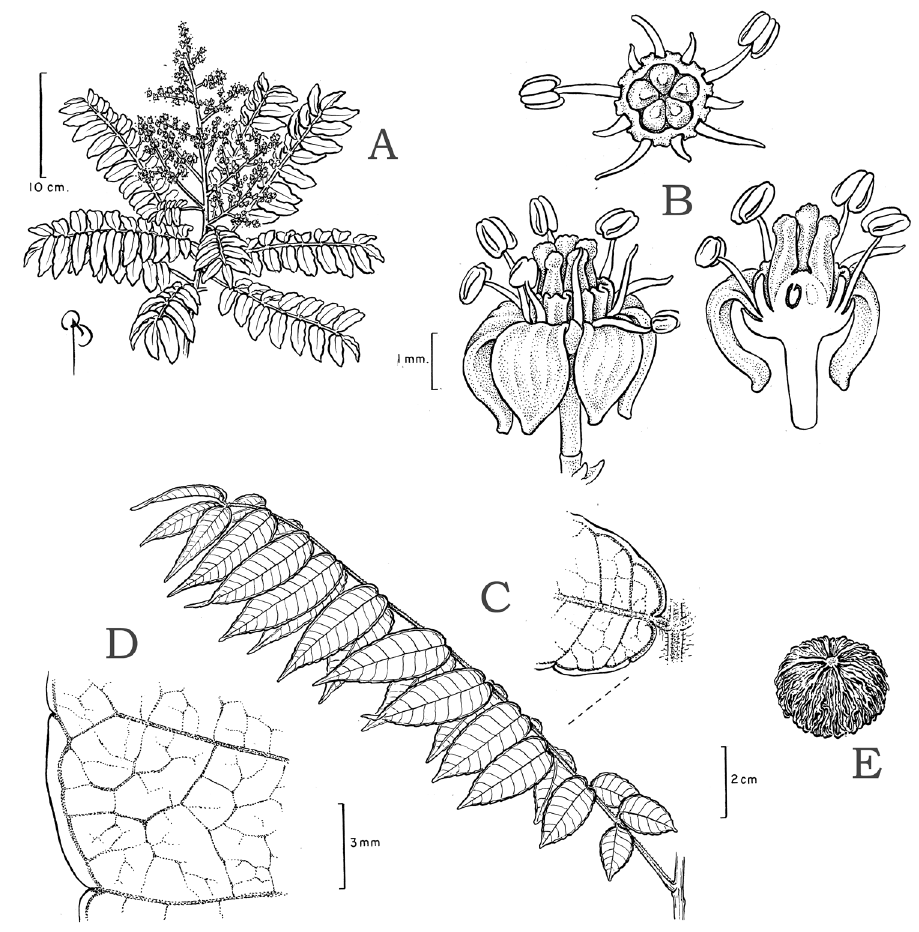
Figure 21. Spondias expeditionaria. A Flowering branchlet B Flower at anthesis and articulated pedicel (left), longisection through flower at center (right), and top view of stamens (most missing anthers), disk, and pistil C Whole leaf and detail of rachis and leaflet base (inset) D Detail of leaflet venation and margin E Endocarp. A–E from Lorenzi s.n.